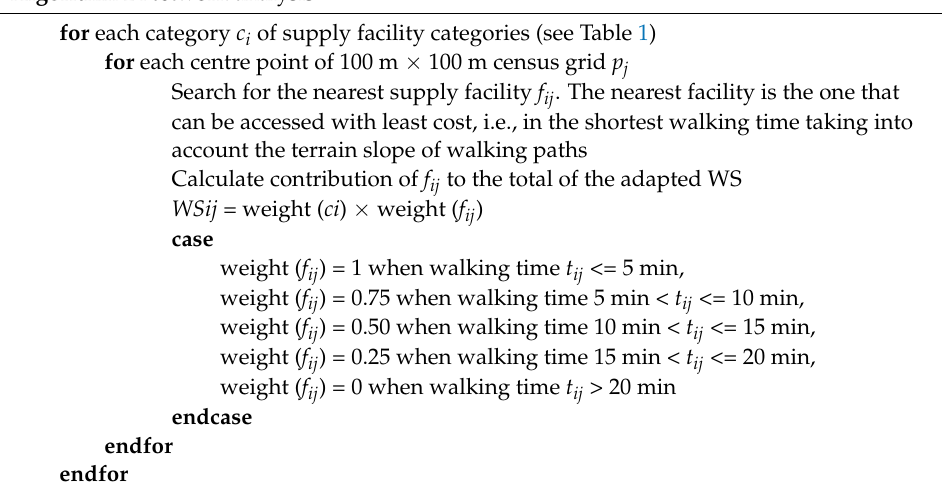
Algorithm 2 Network